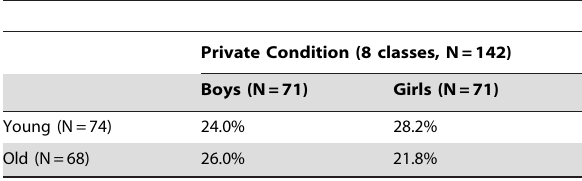
Table 2. Distribution of age groups and gender in Private Condition (in